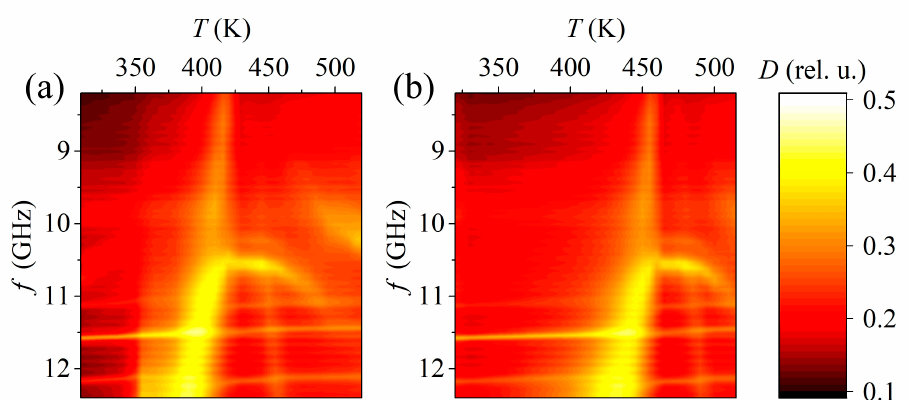
Figure 14. Dependence of absorption coefficient SS of composition 0.97PbZrO 3– 0.03PbTiO 3 on frequency and temperature during heating ( a ) and cooling ( b ). The thermal maps reflect the positions of all features of the absorption spectrum in the temperature and frequency domains.